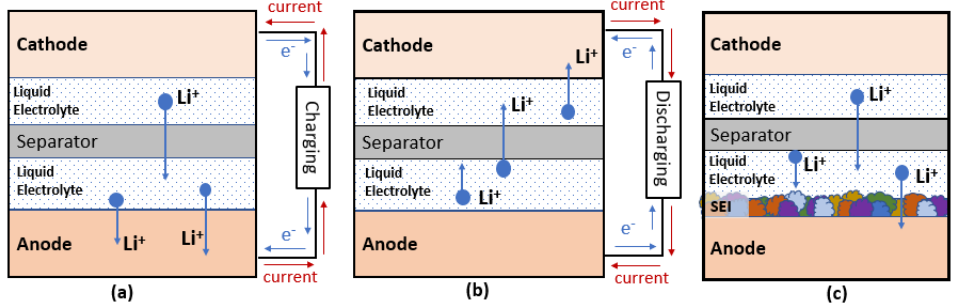
Figure 1. Schematic diagram of LIBs for ( a ) charging ( b ) discharging and ( c ) formation of